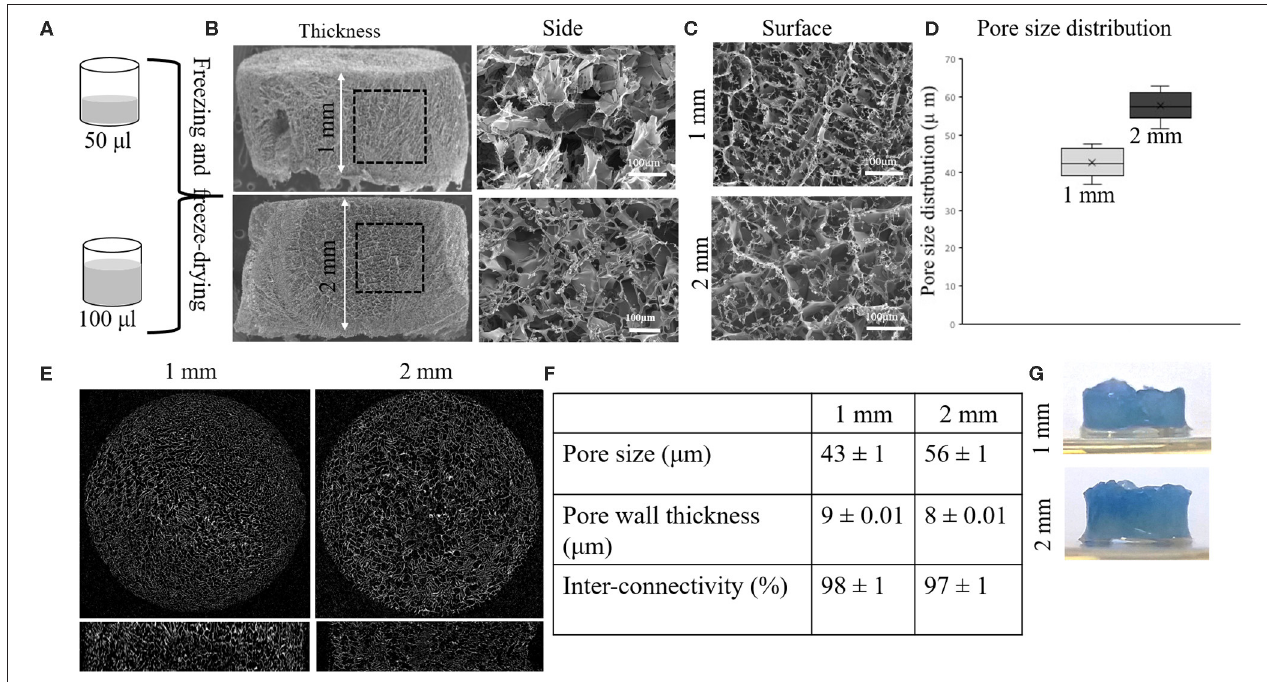
FIGURE 2 | Silk fibroin (SF) scaffolds’ morphological characterization and diffusion. SF scaffolds are obtained pouring 50 µ L and 100 µ L of silk fibroin solution (2 wt %) in a 96 TCPS well plate (A) . Full side (A,B) and high view (200 × magnification, scale bar 100 µ m) of SF 1 and 2mm scaffolds are shown, respectively. Micrographs (C) show the surface profile of the SF scaffolds. The graphs represent the pore size distribution in the two types of SF scaffolds (1mm and 2mm). (D) The pore size distribution is plotted in the graph. Micrographs (E) exhibit the interconnectivity of the porous network in the scaffold with the relative value (F) for the pore size, pore wall thickness and inter-connectivity obtained by means of Micro CT analysis ( n = 3). Alamar blue dye is used to demonstrate liquid diffusion within the scaffolds (G) .